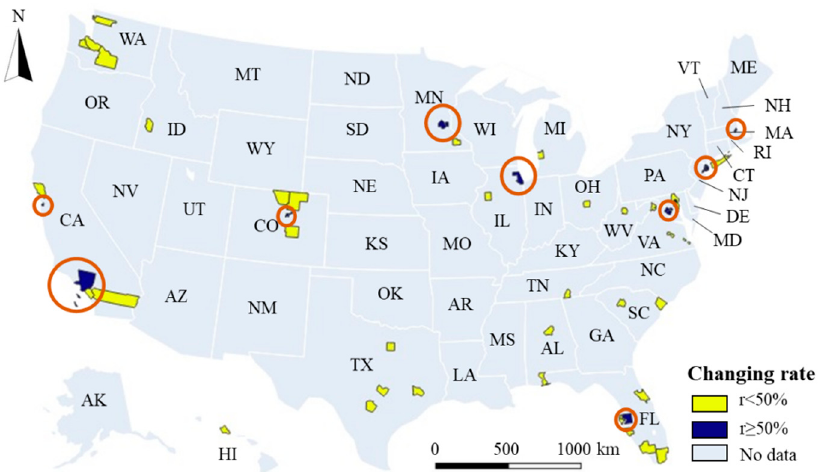
Figure 13. Distribution of burglary changing rate. Red circles denote the research regions where the burglary has increased by more than 50%.